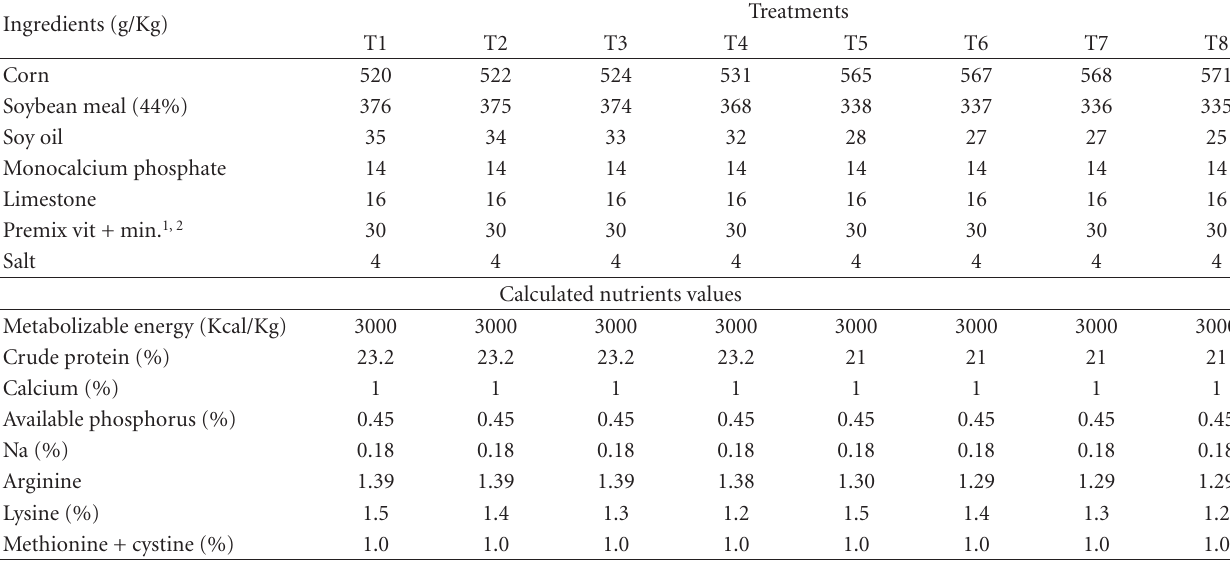
Table 1: The composition and calculated chemical analysis of diets in Experiment